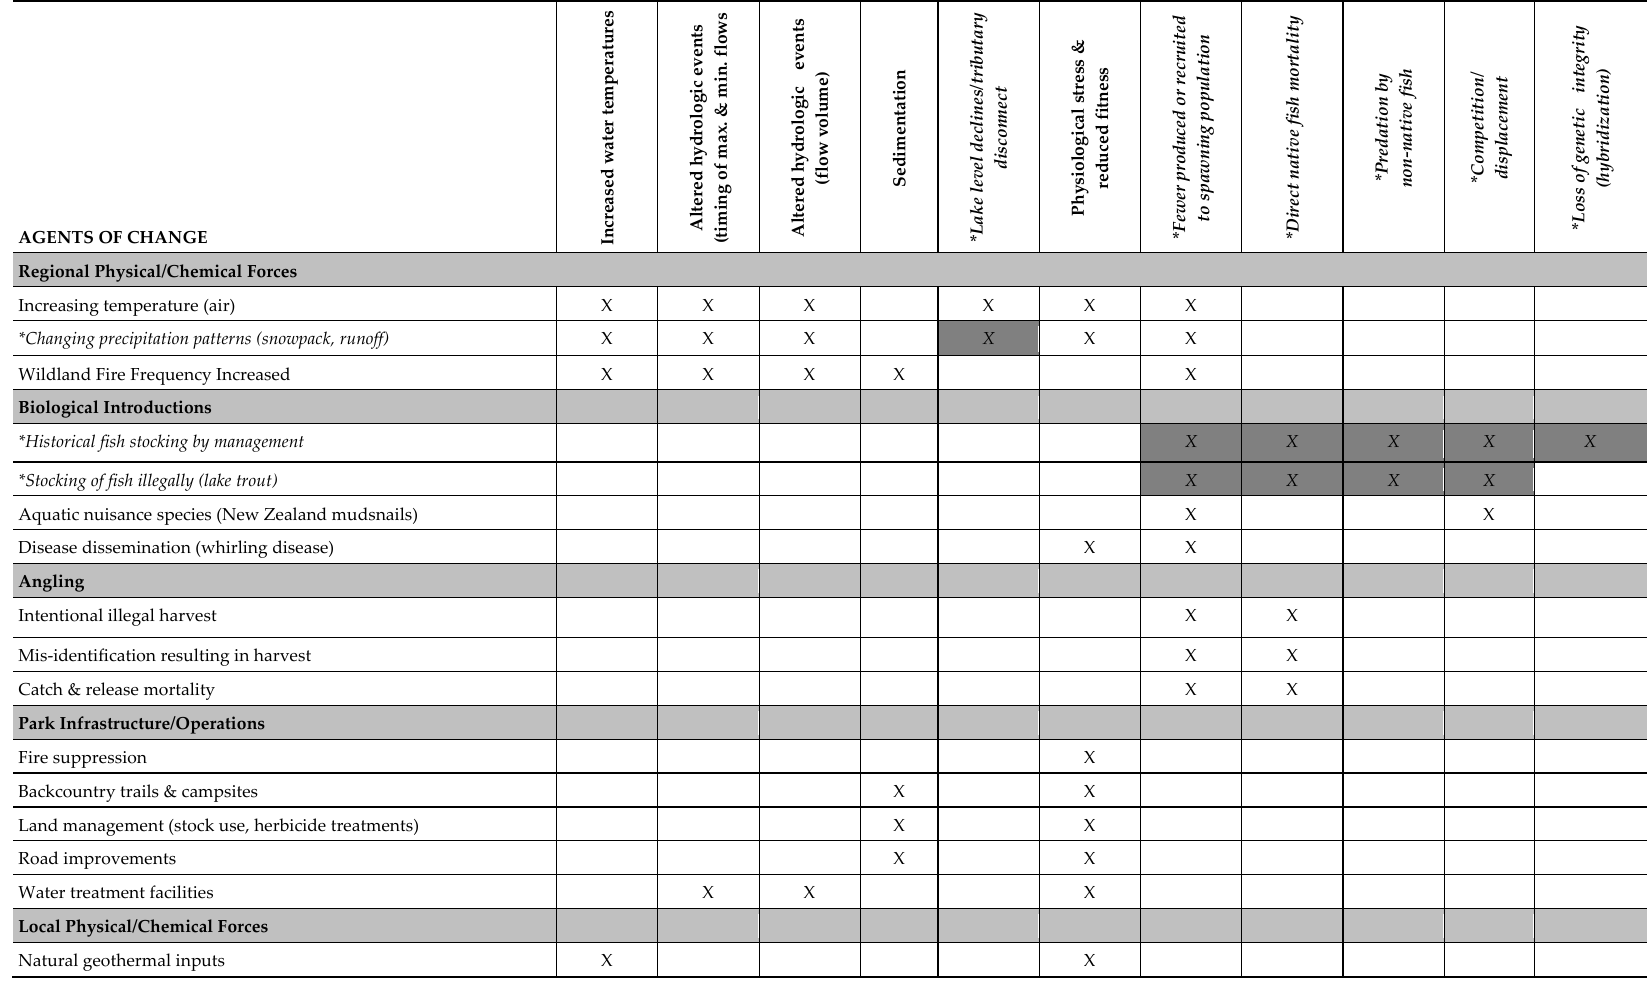
Table A3. Conceptual ecosystem model for the Yellowstone Lake ecosystem restoration. Cells with “X” are hypothesized linkages between agents of change, stressors on native fish, and ecosystem responses. Italic text with asterisks (*) and darkly shaded cells indicate elements addressed by the restoration